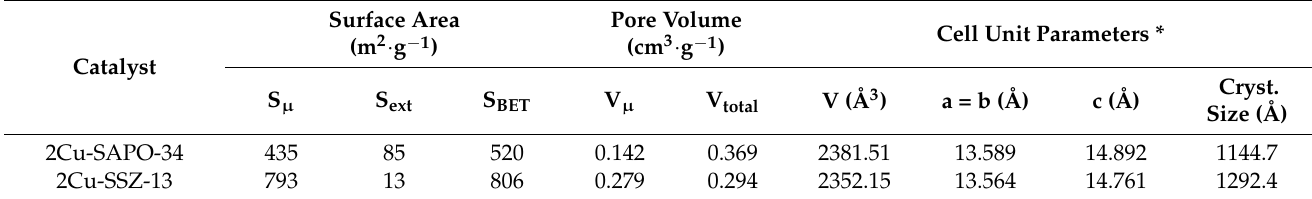
Figure 2. X-ray diffraction patterns of the SCR Cu samples ( a ) 2Cu-SAPO-34 and ( b ) 2Cu-SSZ-13. Table 1. Surface area, pore volume and cell unit parameters of the Cu